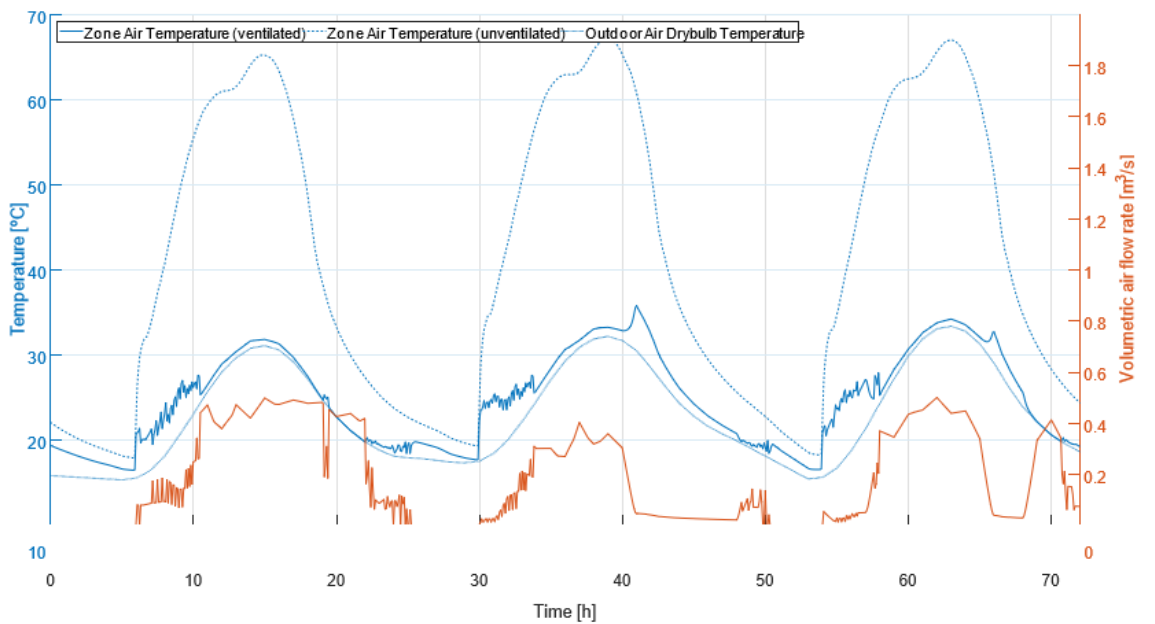
Figure 11. Unconditioned, naturally ventilated and outside temperature of the greenhouse between the 13 and 15 of August.